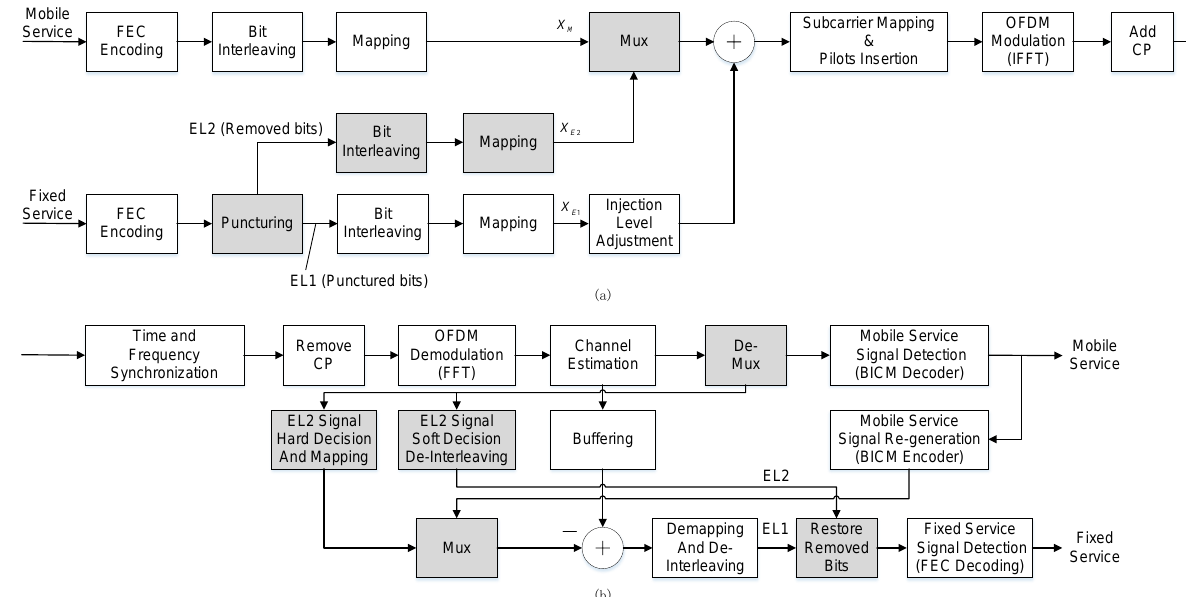
Figure 2. Block diagram of the enhanced LDM (En-LDM) scheme transceiver: ( a ) transmitter: En-LDM scheme that punc- tures LDPC coded bits before symbol modulation; ( b ) receiver.